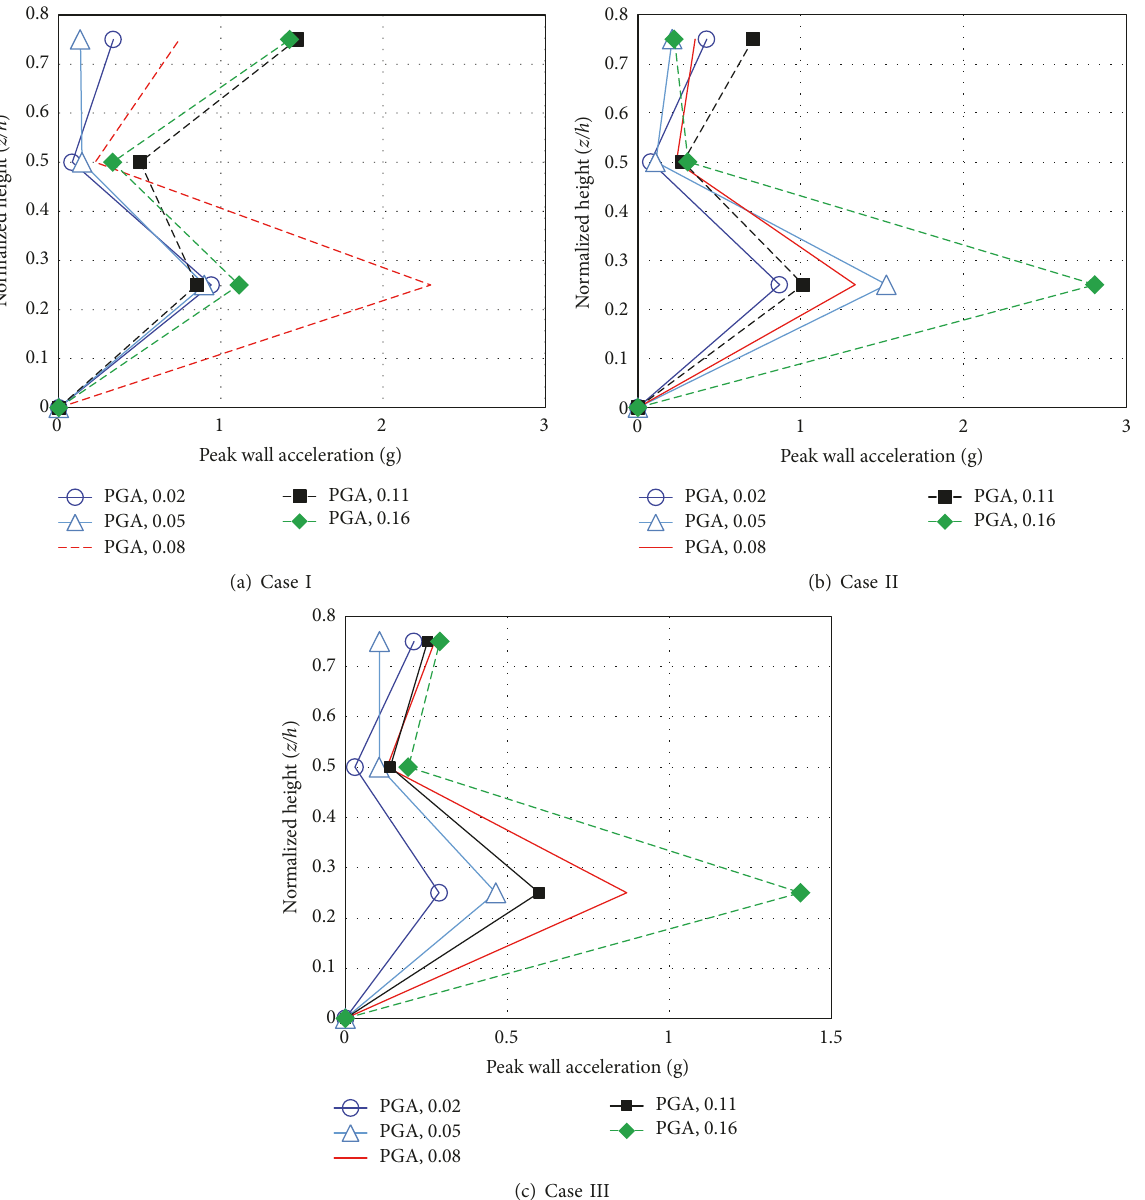
Figure 12: Acceleration response of the walls under El-Centro ground motion with different intensities ( 𝐻/𝐿 = 0.6 ).